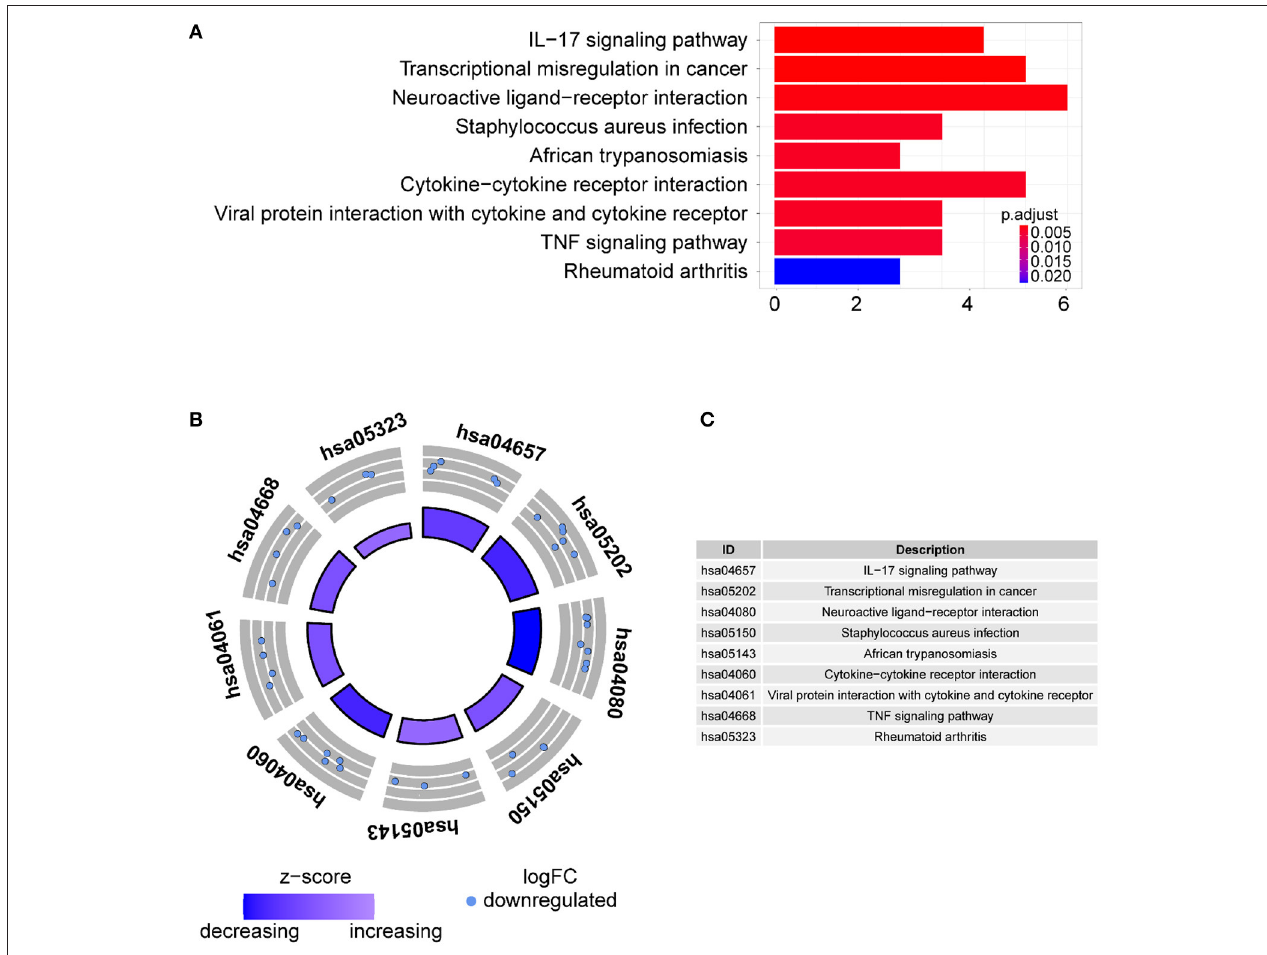
FIGURE 7 | KEGG analysis of the 30 DE-IGs between inflamed and fibrotic livers of BA. (A) The 30 most significantly enriched KEGG pathways are displayed in the barplot. The length of the bar represents the number of genes enriched, and the color represents the correlation. (B) The circle of KEGG pathways enrichment analysis. Each dot in the circle represents a gene, and the outer circle reflects the enrichment of the DE-IGs in different signaling pathways. The inner circle represents the Z-score, the color depth corresponding to the Z-score. Higher Z-score indicates a higher expression of the DE-IGs in enriched pathways. (C) The table annotates KEGG